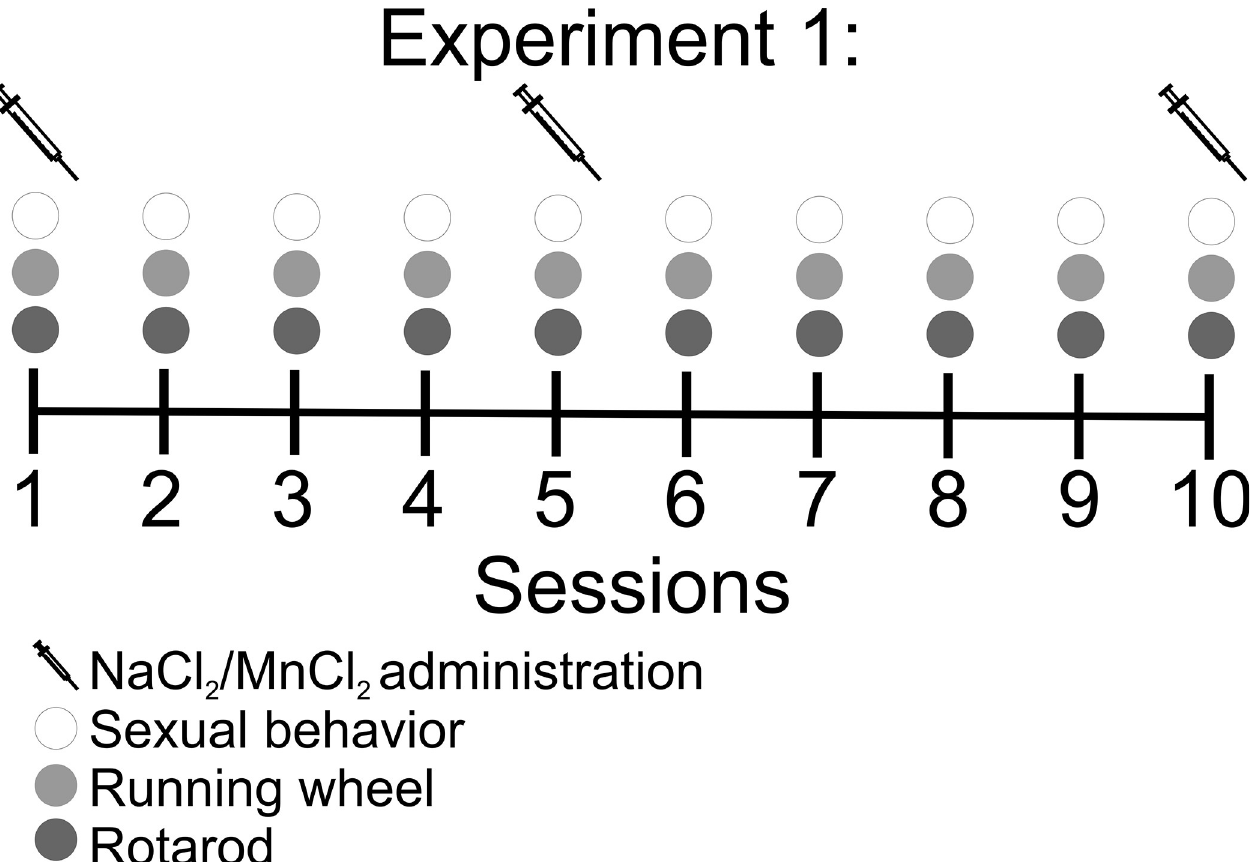
Fig 1. Timeline of the behavioral tests to evaluate the effects of manganese administration. Subjects were tested once a week for 10 consecutive weeks for sexual behavior, immediately followed by running wheel and then by the rotarod test. Twenty-four hours before sessions 1, 5 and 10 subjects were injected with saline,8 or 16 mg/kg of MnCl 2